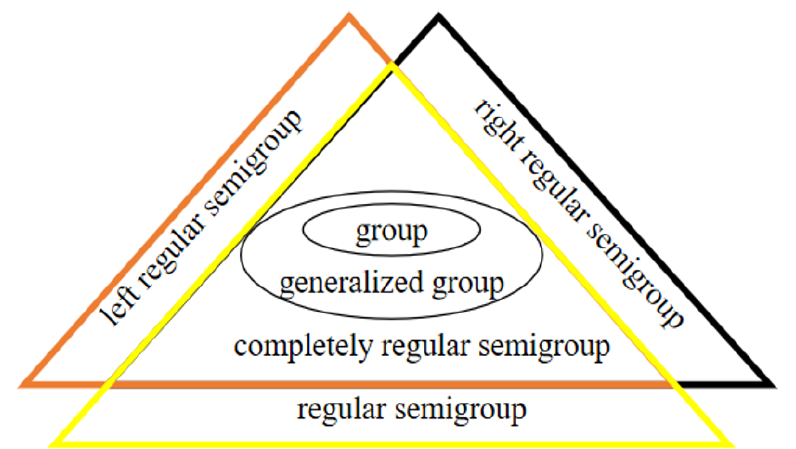
Figure 1. The relationship among various associative